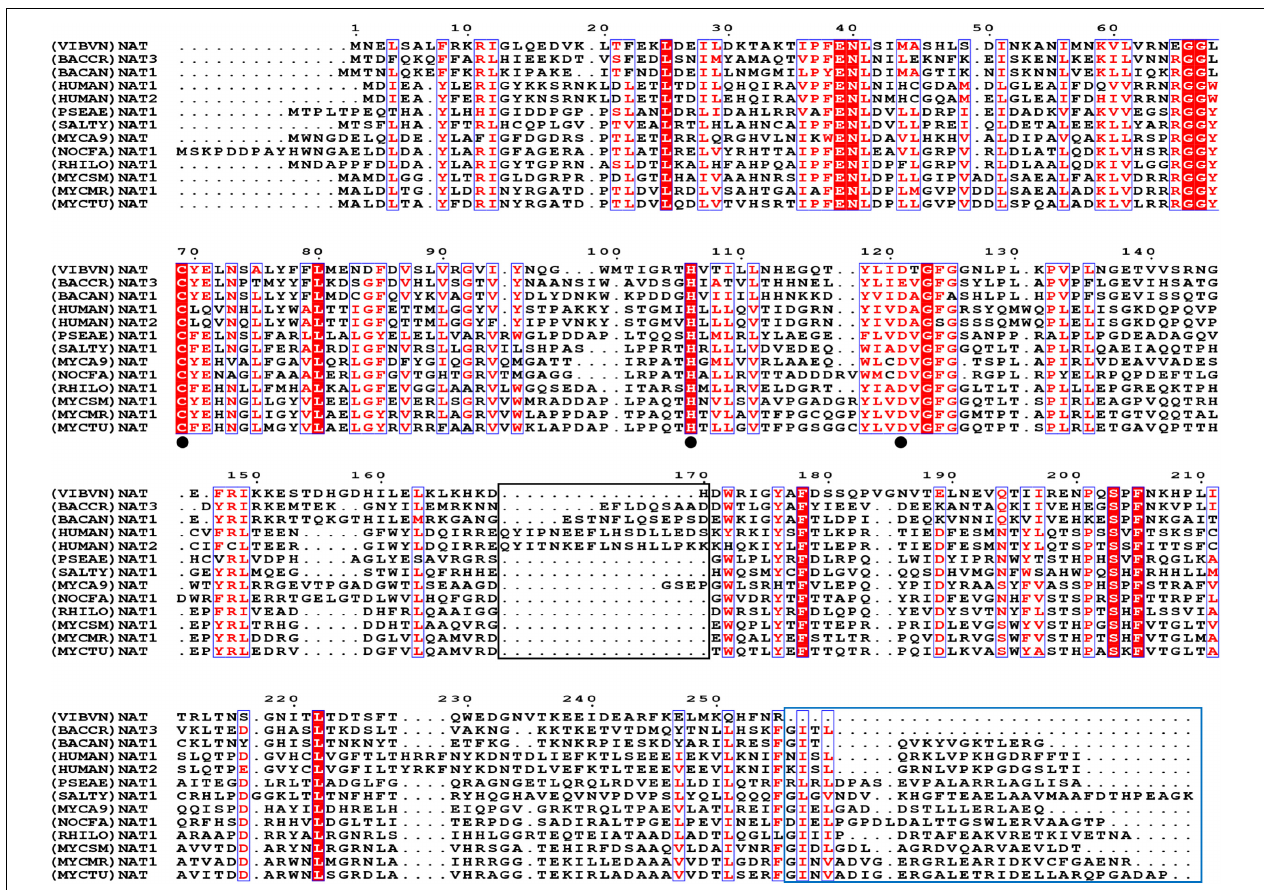
FIGURE 1 | The amino acid sequence alignment results. Comparison of (VIBVN)NAT with 10 bacterial NAT proteins and two human NAT proteins, Bacillus cereus (BACCR), Bacillus anthracis (BACAN), Homo sapiens (HUMAN), Pseudomonas aeruginosa (PSEAE), Salmonella typhimurium (SALTY), Rhizobium loti (RHILO), Mycobacterium smegmatis (MYCSM), Mycobacterium abscessus (MYCA9), Nocardia farcinica (NOCFA), Mycobacterium marinum (MYCMR), and Mycobacterium tuberculosis (MYCTU). Fully conserved residues are highlighted in a red background, and semi conserved residues are highlighted in red font. The black frame indicates the “mammalian/eukaryotic insertion loop.” The blue frame indicates the lack of the C-terminal region. The catalytic triad is indicated by a black